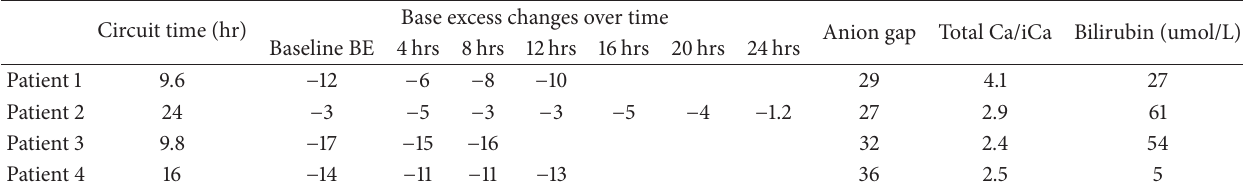
Table 2: Acid-base profile of the four patients with citrate accumulation during citrate CRRT. Circuit time